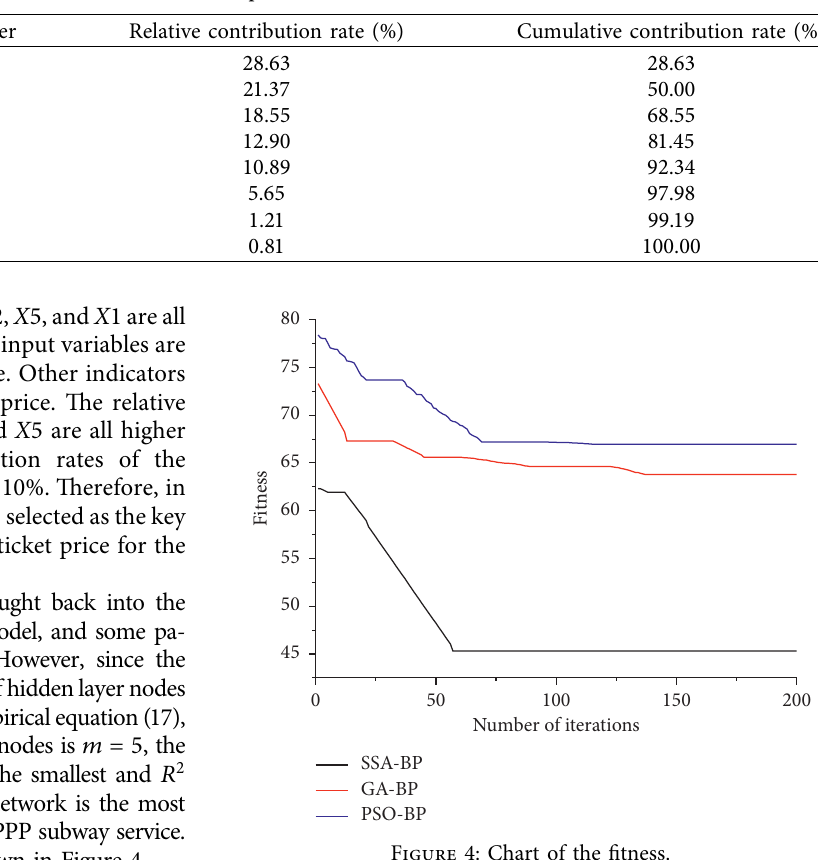
Table 5: Calculation results of the input variables based on MIV.